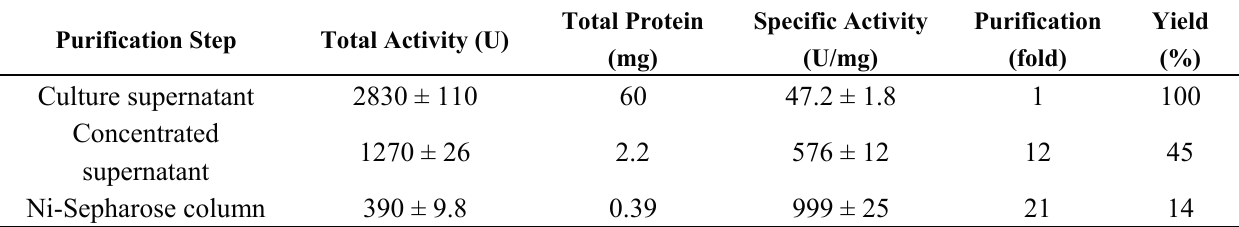
Table 1. Summary of the purification of recombinant HydS14 in P. pastoris strain